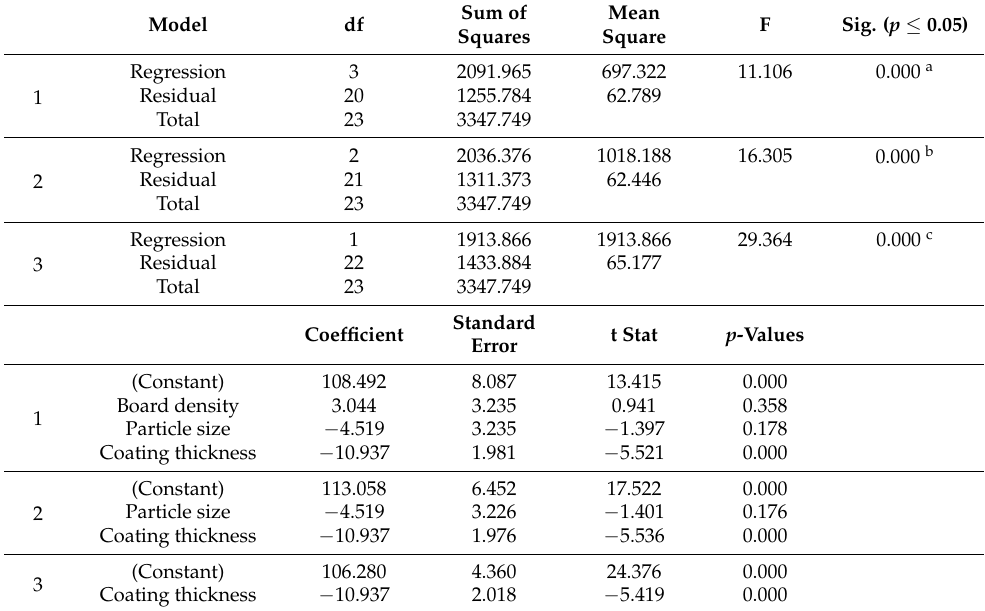
Table 3. Analysis of variance (ANOVA) of multiple regression for the effect of PU coating thickness, different particle size, and board density on the contact angle (CA)